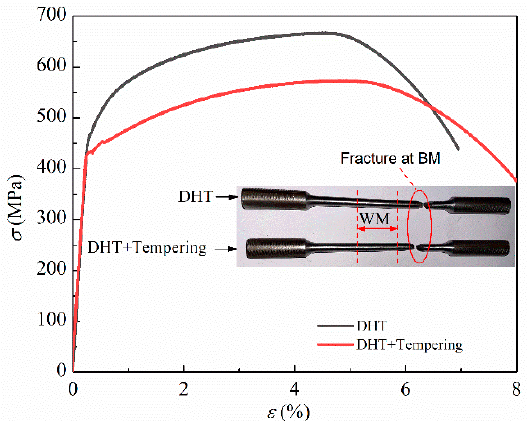
Figure 17. Tensile stress ( σ )-strain ( ε ) curves of the 12Cr1MoV steel welded joints after DHT or after tempering heat treatment. tempering heat